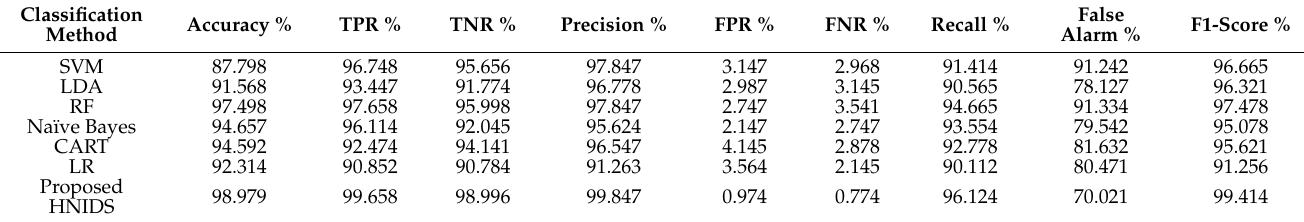
Table 8. Experimental result of BCC on KDD-Train + dataset.